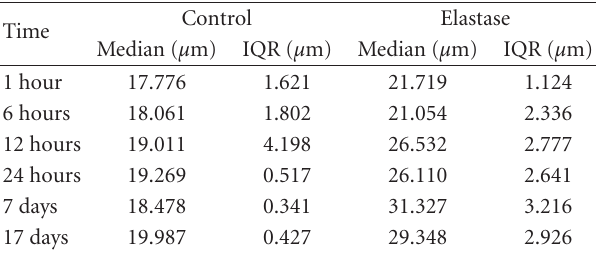
Table 2: Evolution of L m at the experiment time points after elastase